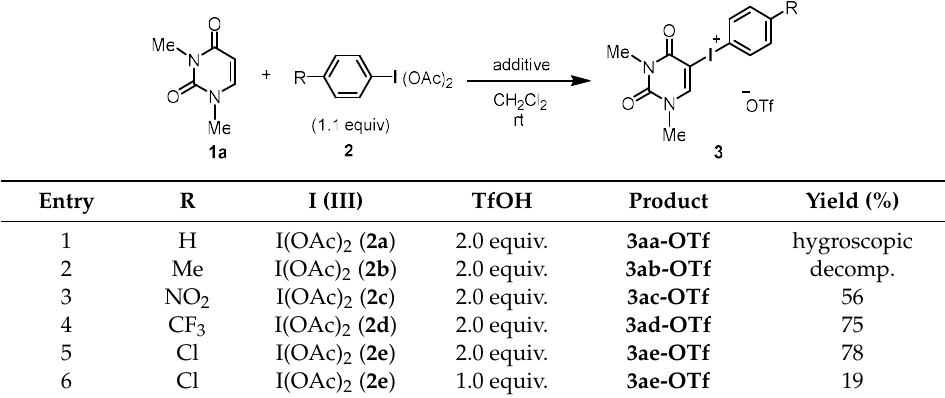
Table 1. Influence of substituents on benzene ring of uracil-iodonium(III) triflates.